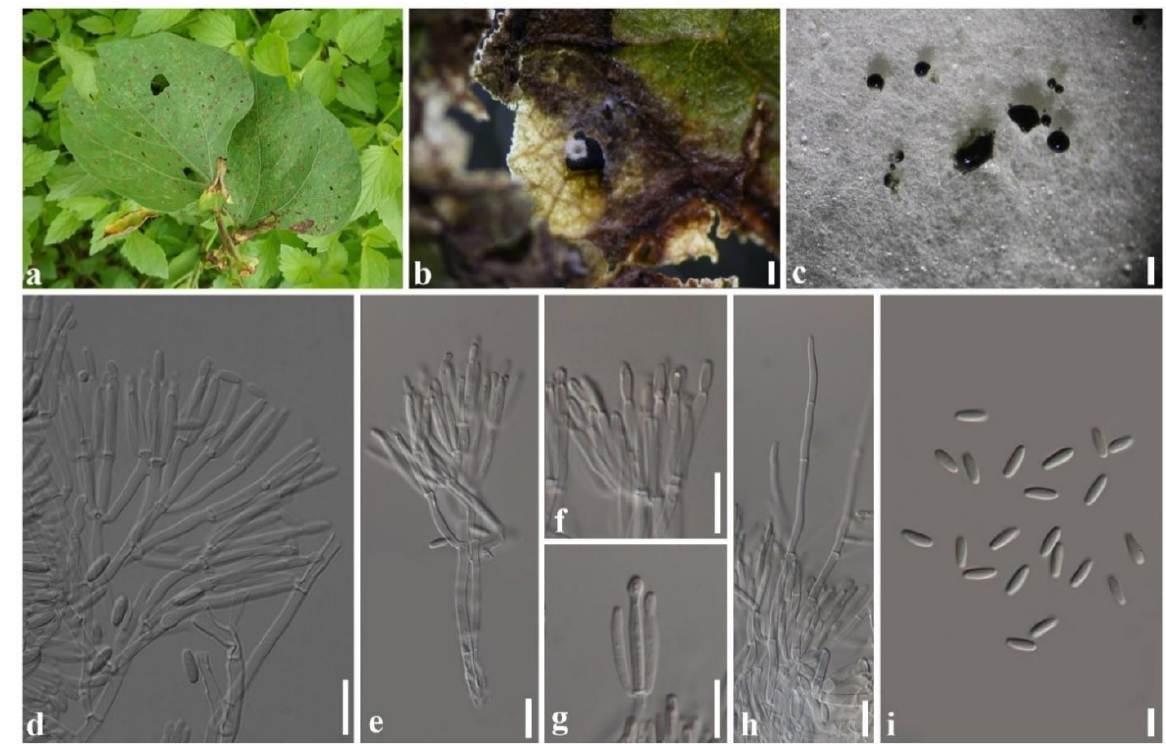
Figure 4. Paramyrothecium vignicola (CRC4-H, holotype); ( a ) leaf spot of Vigna sp.; ( b ) sporodochia on leaf; ( c ) sporodochial conidiomata on PDA; ( d , e ) conidiophores and conidiogenous cells; ( f , g ) conidiogenous cells; ( h ) setae; ( i ) conidia. Scale bars: ( b , c ) = 1 mm; ( d – h ) = 10 µm; ( i ) = 5 µm. Table 1. Synopsis of Paramyrothecium type species.